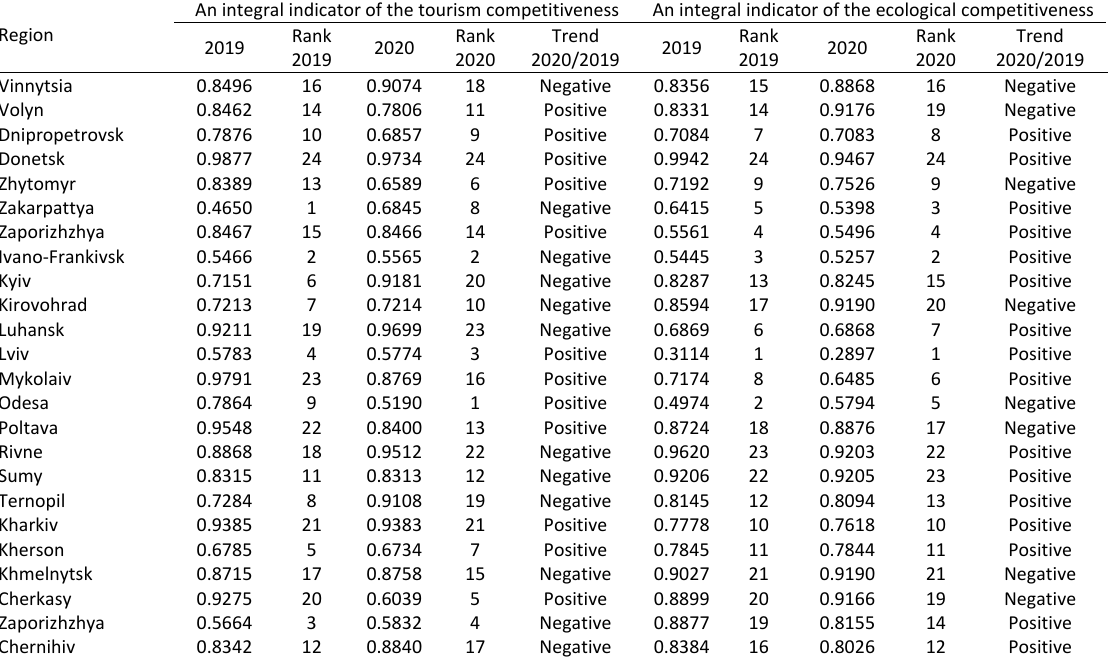
Table 2: The ecological and tourism competitiveness of Ukrainian regions